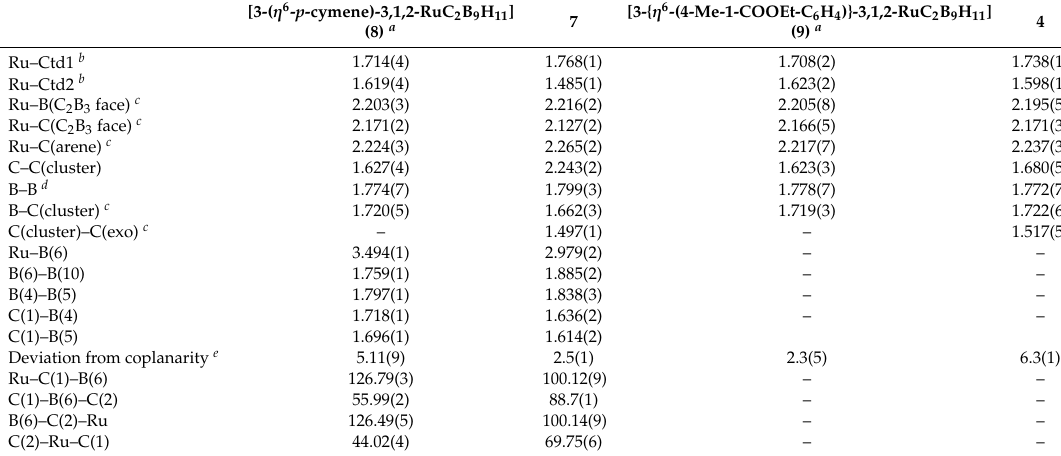
Figure 3. Molecular structures of 4 ( left ) and 7 ( right ). Thermal ellipsoids are shown at the 50% probability level. Hydrogen atoms are omitted for clarity. Numbering of selected boron and carbon positions is given. Table 1. Selected bond lengths, distances (Å) and angles ( ◦ ) in 4 and 7 , and the respective unsubstituted ruthenacarboranes 8 and 9